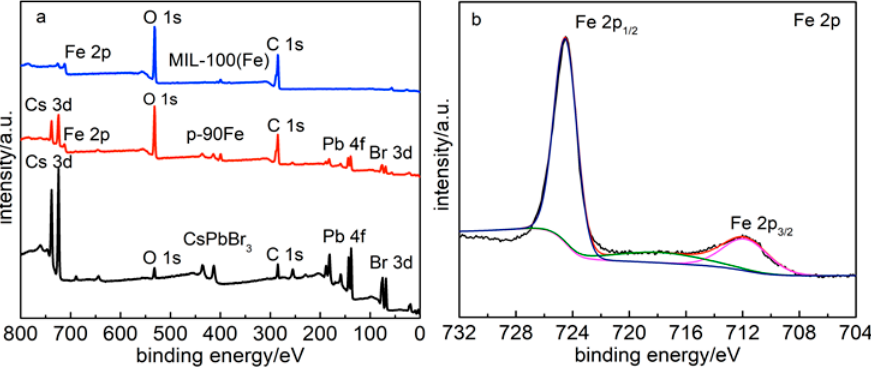
Figure 3. XPS spectra of p-90Fe: ( a ) survey and ( b ) Fe 2p.